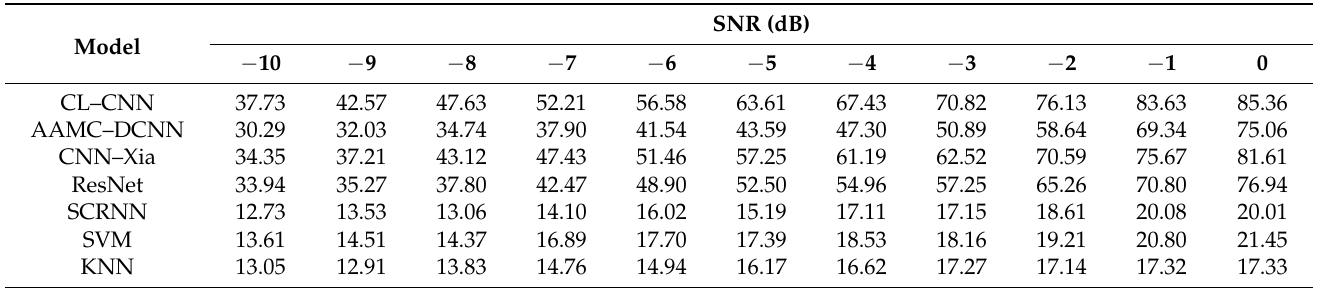
Table 10. Classification performances of the deep models, and the traditional methods with the sample size for each class being 15 based on the first dataset.